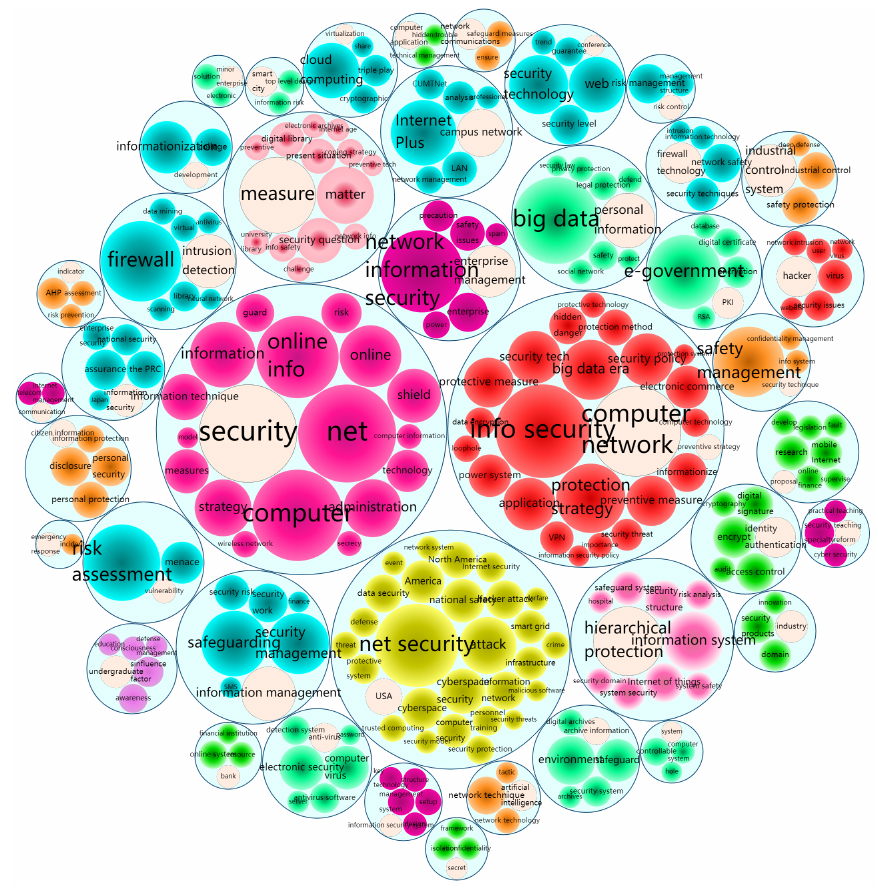
Figure 3. Topic clustering results of high frequency